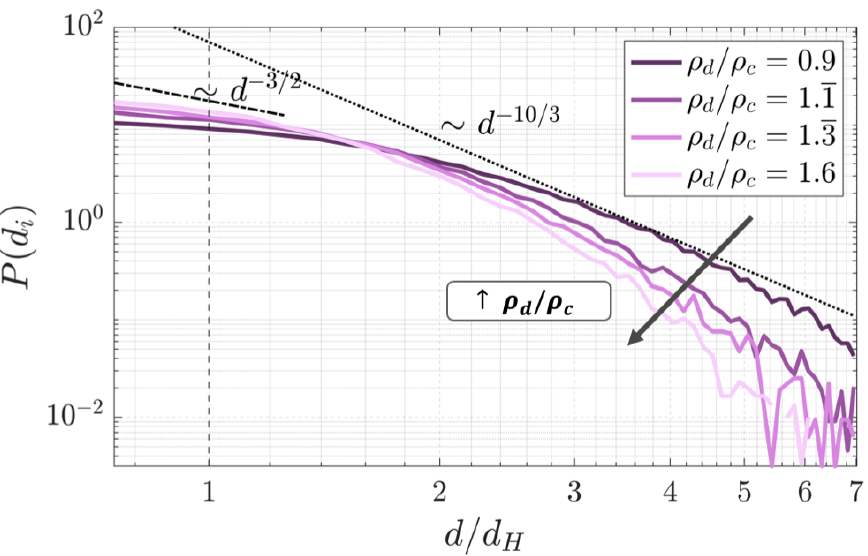
Figure 4. Drop size distribution of the different density ratios together with the scaling laws of Deane and Stokes [7] and Garret et al.